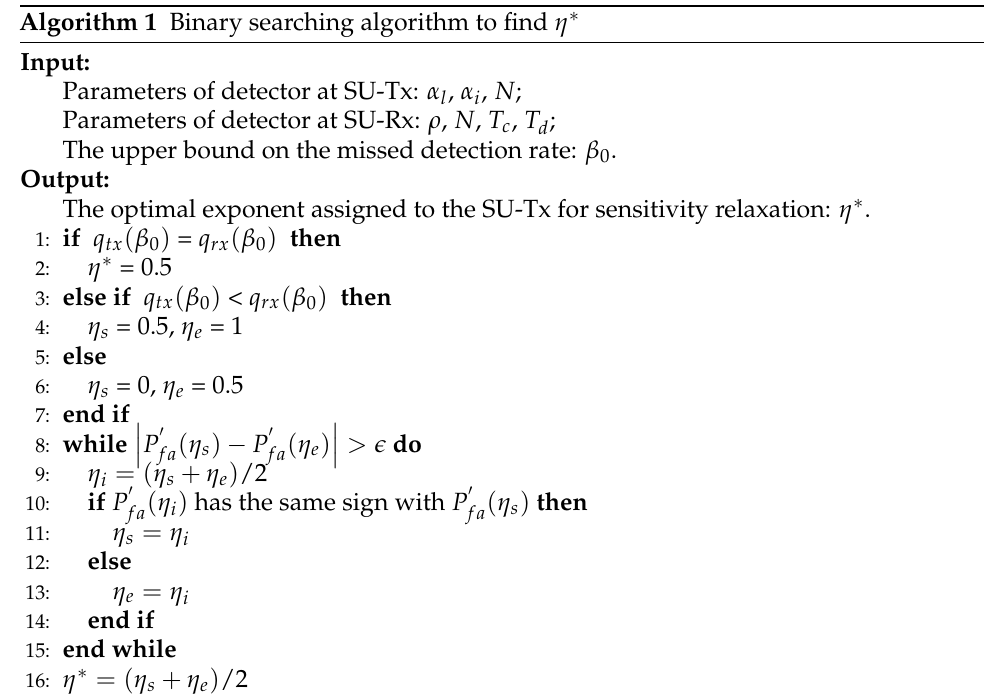
Algorithm 1 Binary searching algorithm to find η